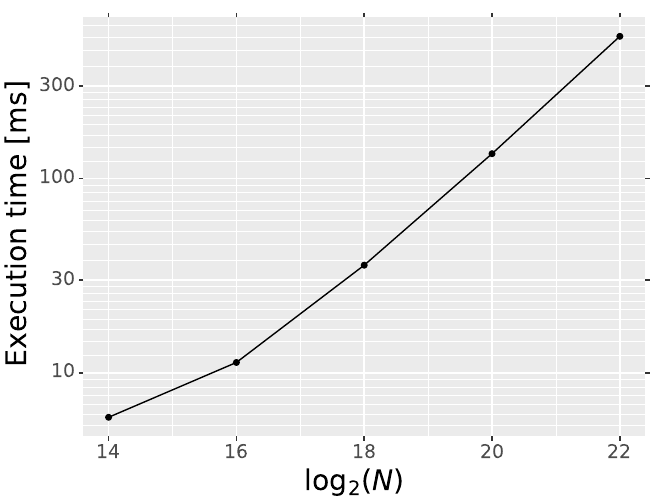
Figure 17. Execution time dependency of the IDCNN on the number of image pixels N